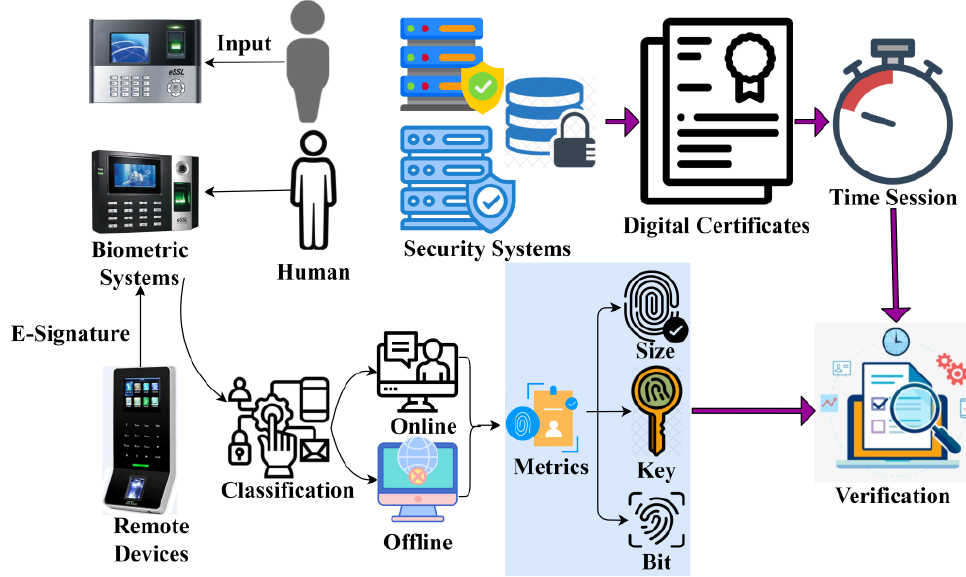
Figure 1. DSVT-MC illustration.